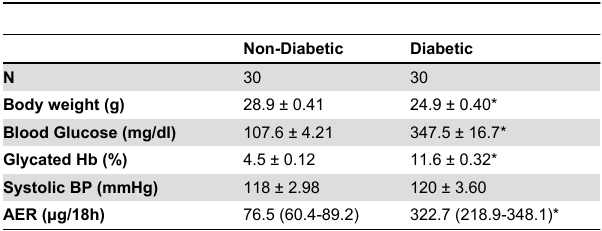
Non-Diabetic Diabetic